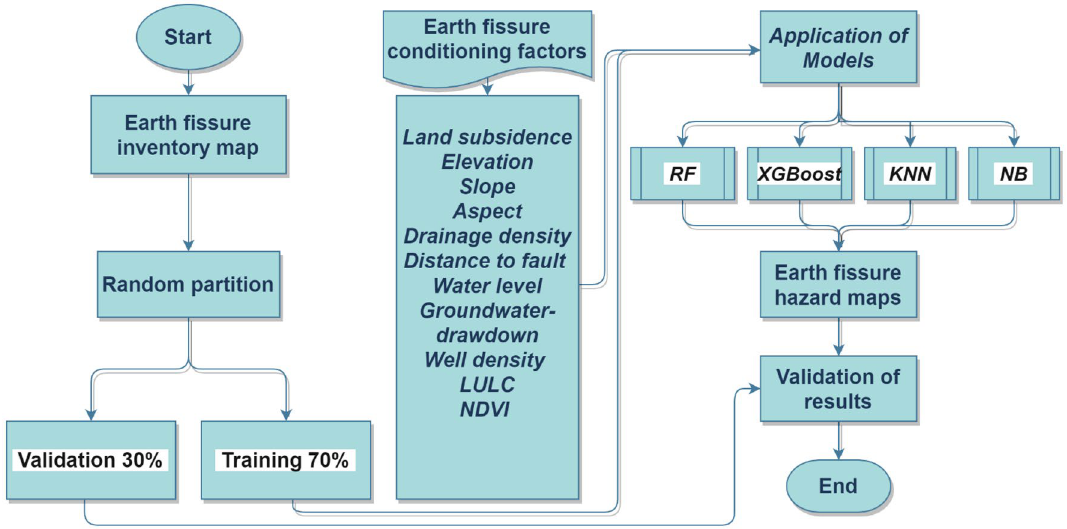
Figure 3. Methodology flowchart (Developed by the first author using draw.io (v. 14.9.6), https:// www. diagr ams.